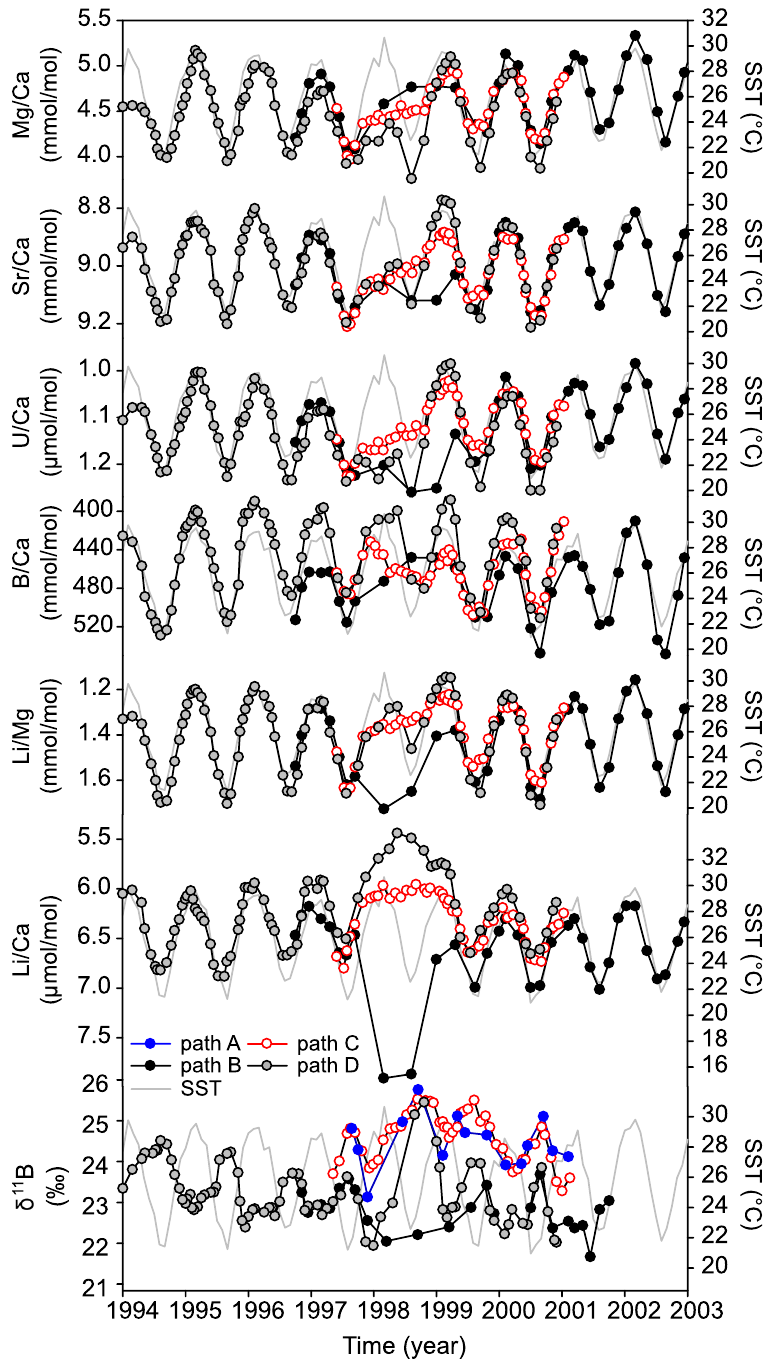
Figure 3. Untreated (uneven time-distance) trace element and boron isotopes records centred around 1998 for the four different sample paths (see Fig. 2) compared to monthly SST. The records in their full length are presented in the supplementary